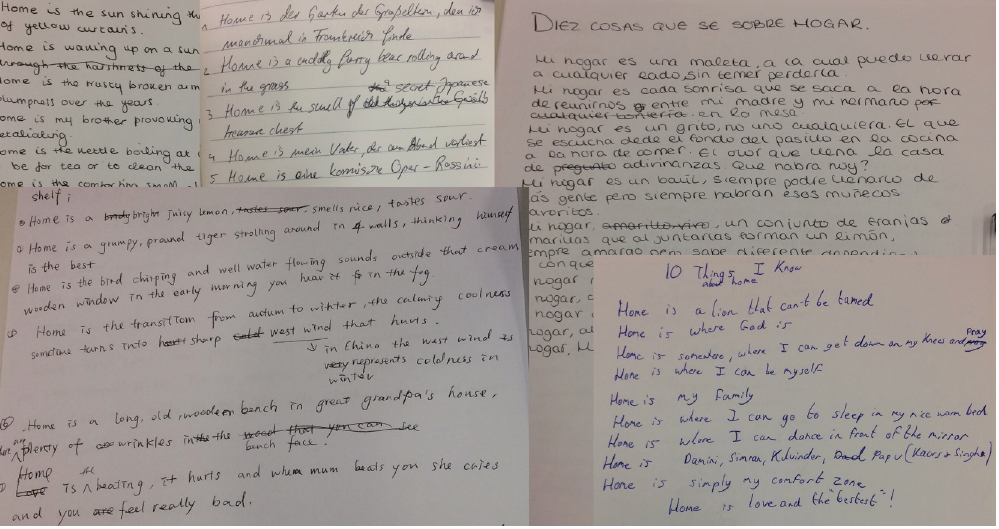
Figure 3. Draft poems and notes for poems produced by participants of a workshop with Deryn Rees-Jones on May 4, 2017, Europe House, London” © Ricarda